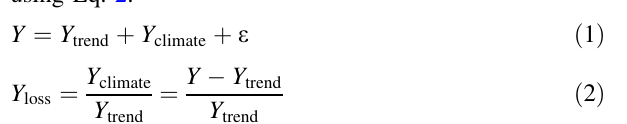
Table 6 Frost threshold for key growth stages of maize and wheat. Source CMA (2008) Crop Seeding